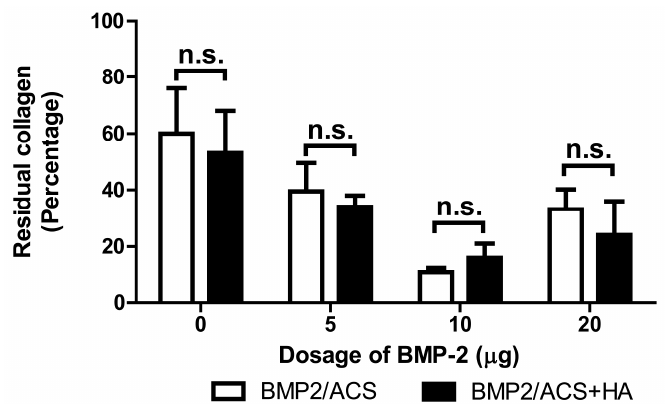
Figure 4. Mean volumes of residual collagen carrier material of the BMP-2/ACS constructs, in the presence or absence of 100 μ g/mL HA (48 kDa) implanted at different BMP-2 dosages, 18 days after implant placement. Values represent means ± SEM; n = 6 per experimental group. n.s.: denotes the absence of significant differences ( p > 0.05). The compared groups are indicated by brackets.